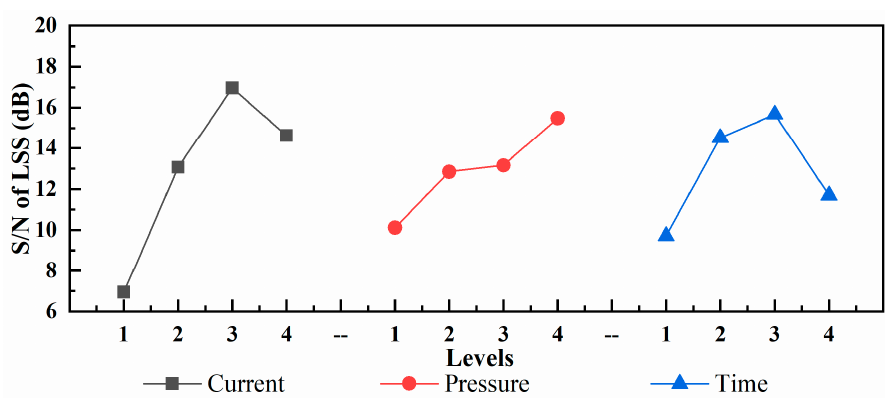
Figure 7. Mean S/N value under different levels of various factors.